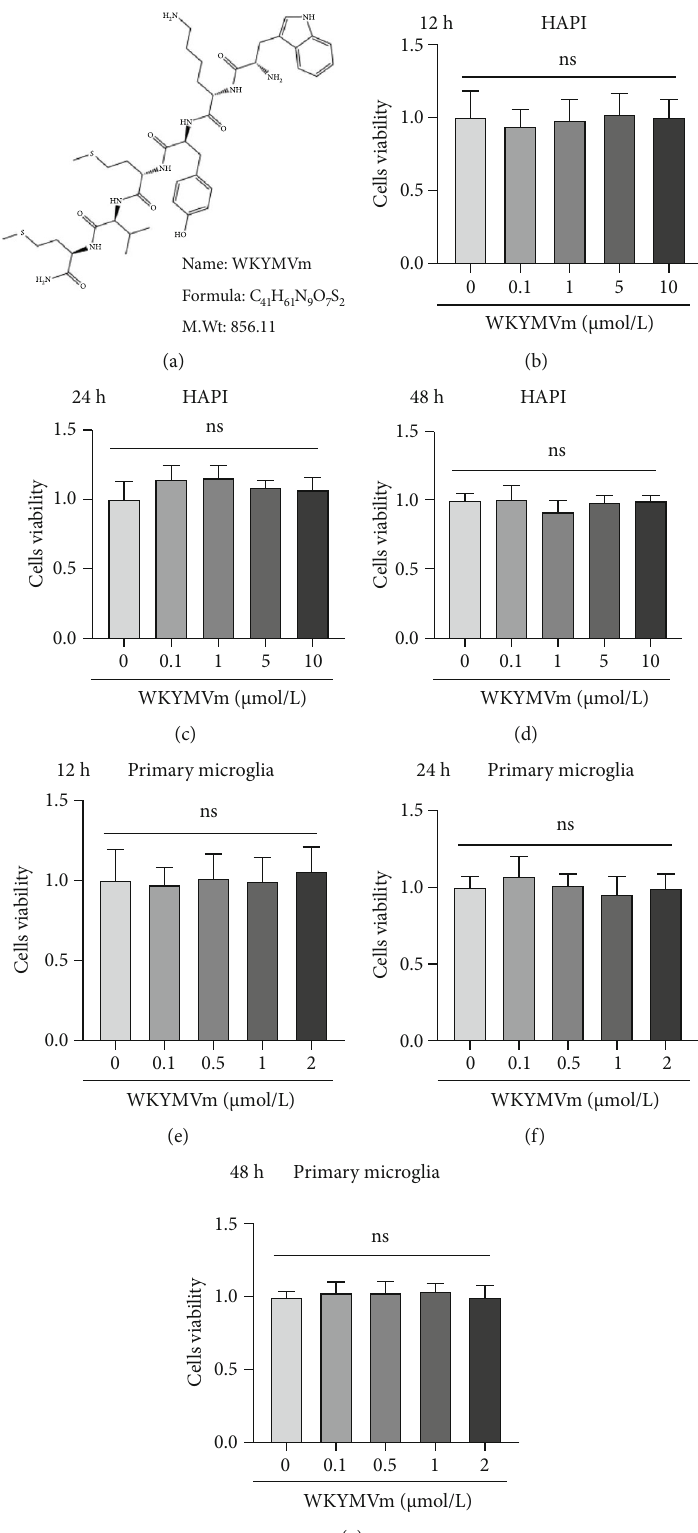
Figure 1: WKYMVm had no e ff ect on microglial proliferation or viability. (a) The molecular structure of WKYMVm. Cytotoxic e ff ects of WKYMVm on HAPI microglia and primary microglia were examined by the CCK-8 assay. (b – d) HAPI microglia were incubated with increasing concentrations (0, 0.1, 1, 5, and 10 μ mol/l) of WKYMVm for 12h, 24h, and 48h at 37 ° C. (e – g) Primary microglia were incubated with increasing concentrations (0, 0.1, 0.5, 1, and 2 μ mol/l) of WKYMVm for 12h, 24h, and 48h at 37 ° C. M.Wt: molecular